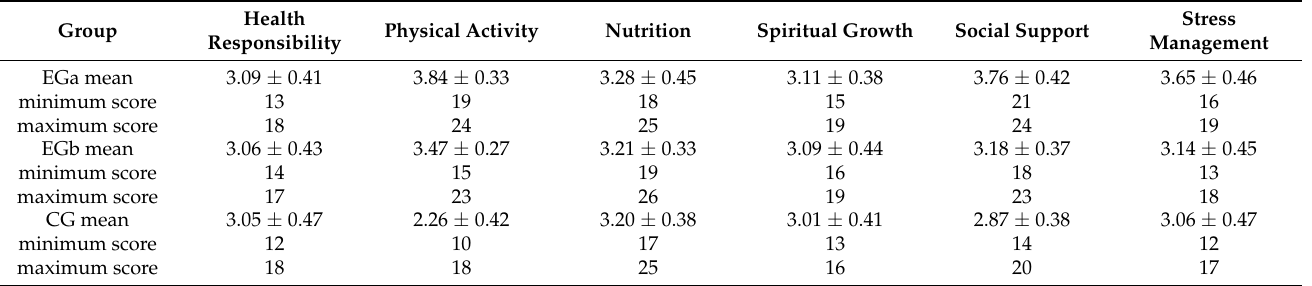
Table 5. The lowest, highest, and mean scores of different aspects of the Health-Promoting Lifestyle Profile